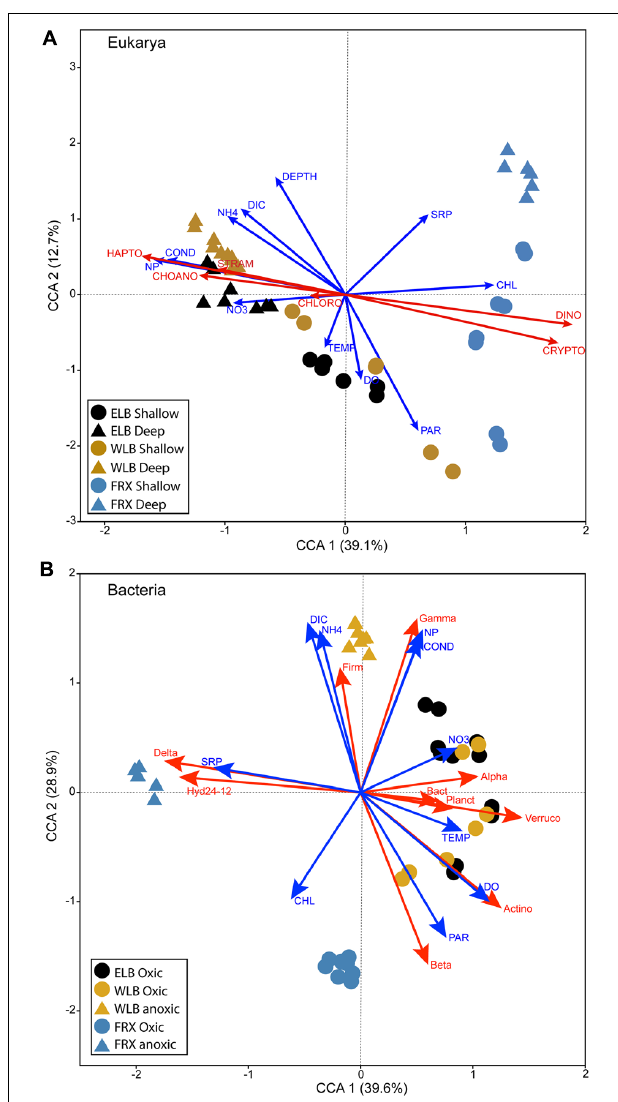
FIGURE 5 | Canonical correspondence analysis (CCA) plots showing corresponding relations between eukaryal (A) and bacterial (B) communities to physicochemical and biological factors in the east and west lobes of Lake Bonney (ELB and WLB, respectively) and Lake Fryxell (FRX). Shallow: epilimnion; Deep: chemocline + hypolimnion. Oxic and anoxic: upper oxic zone and deep anoxic zone in the water columns, respectively. TEMP, temperature; COND, conductivity; PAR, photosynthetically active radiation; NH 4 , ammonium; NO 3 , nitrate and nitrite; NP, N:P ratio; DO, dissolved oxygen; SRP, soluble reactive phosphorus; DIC, dissolved inorganic carbon; Chl, chlorophyll a. Algal abundance: CHLORO, chlorophytes; CRYPTO, cryptophytes; CHOANO, choanoflagellates; DINO, dinoflagellates; HAPTO, haptophytes. Bacterial abundance: Alpha, Alphaproteobacteria; Beta, Betaproteobacteria; Gamma, Gammaproteobacteria; Delta, Deltaproteobacteria; Actino, Actinobacteria; Bact, Bacteroidetes; Firm, Firmicutes; Planct, Planctomycetes; Verruco, Verrucomicrobia.